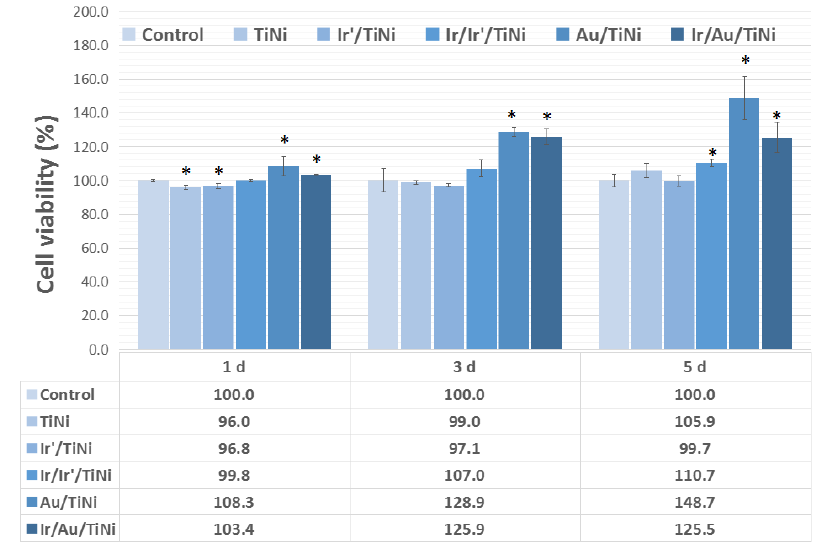
Figure 13. Viability of Man-1 cells cultured for 1, 3 and 5 days in 100% extraction medium obtained using TiNi substrates and those coated with noble metal films: Ir’/TiNi, Au/TiNi, Ir/Ir’/TiNi and Ir/Au/TiNi samples. * p < 0.05.